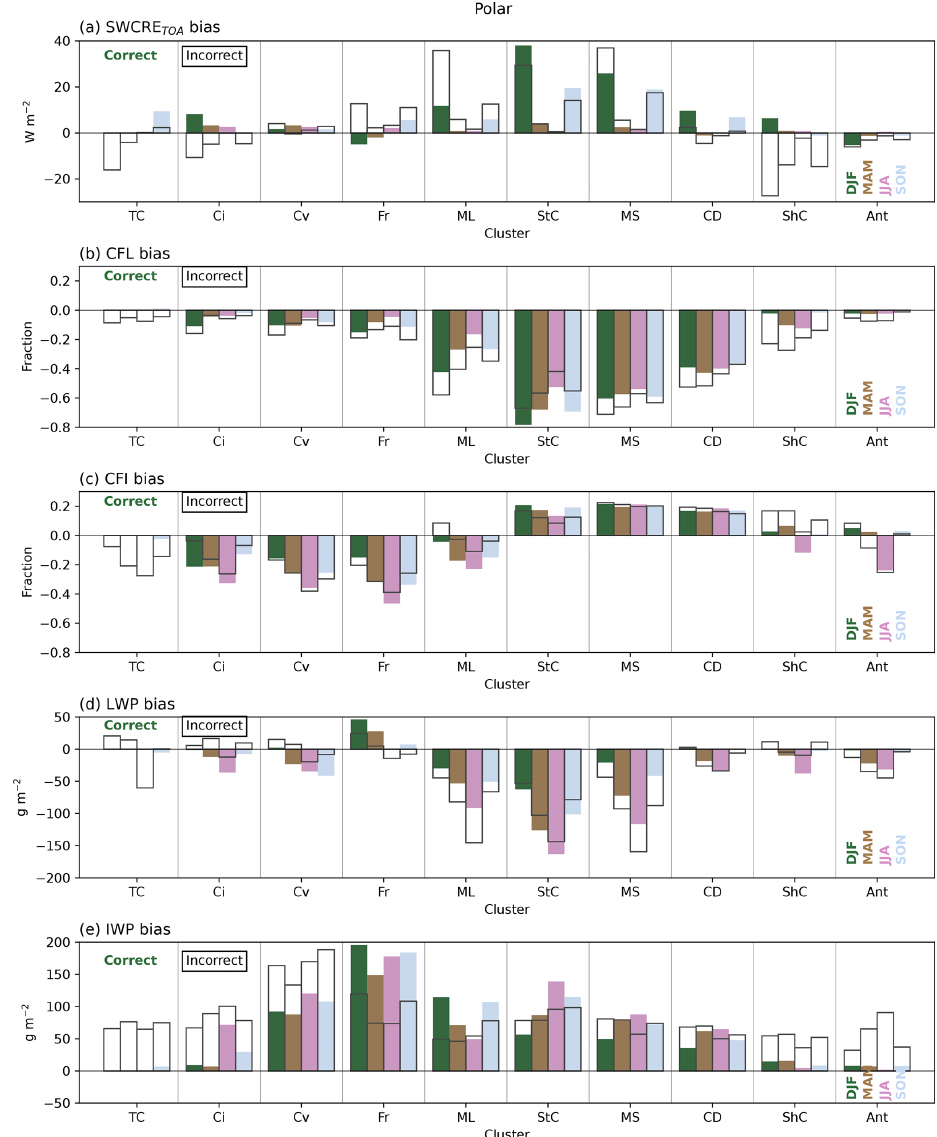
Figure 10. The same as Fig. 8 but for the polar